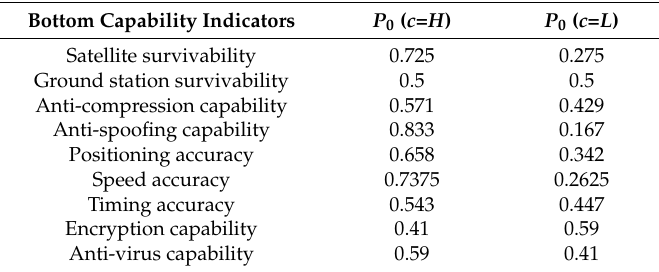
Figure 4. Conditional probability distribution (CPD) of spatial navigation and positioning capabilities. Similarly, the determination of the prior probability of the underlying ability index also requires an accurate probability judgment. Cognitive uncertainty, should it occur, must be assigned to the definite states, as shown in Table 5. Table 5. The prior probability of bottom capability